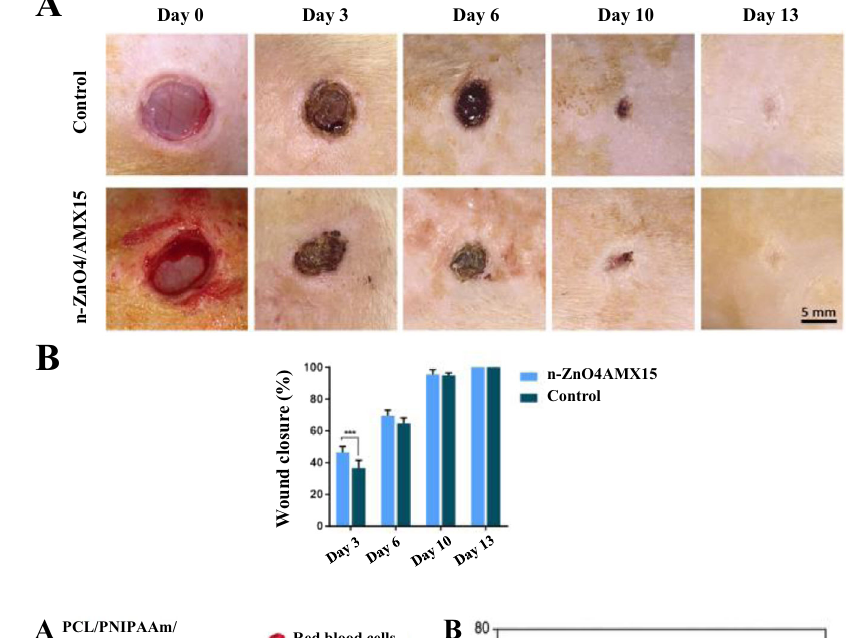
NattokinaseRed blood Platelets